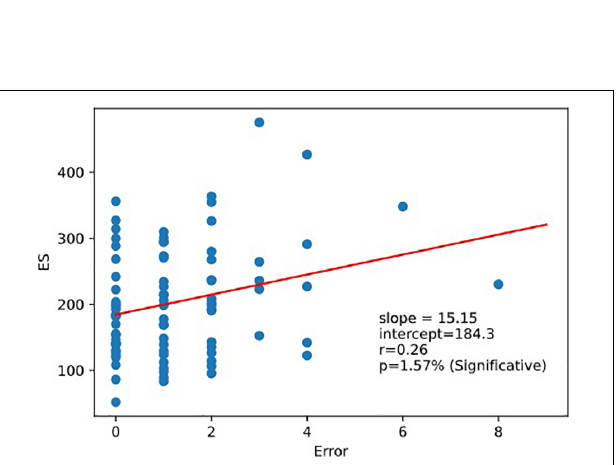
FIGURE 8 | Correlation RD vs.depression.Reaction to dfficulty (RD) is correlated to depression score of the Hospital Anxiety and Depression Scale (HADS).